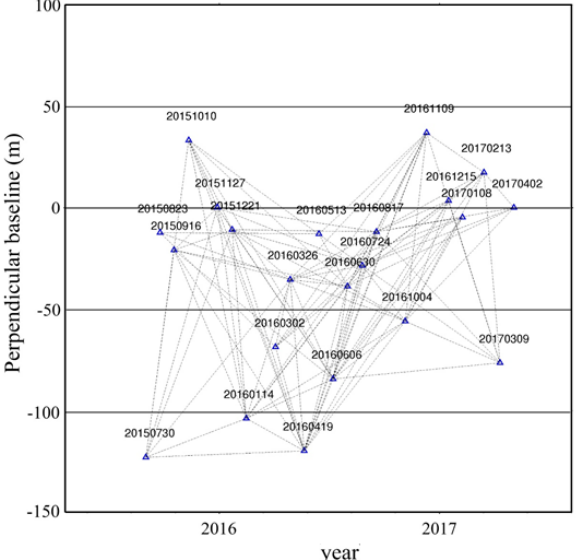
Figure 4. Spatial and temporal baselines of Sentinel TOPS SAR images used in this